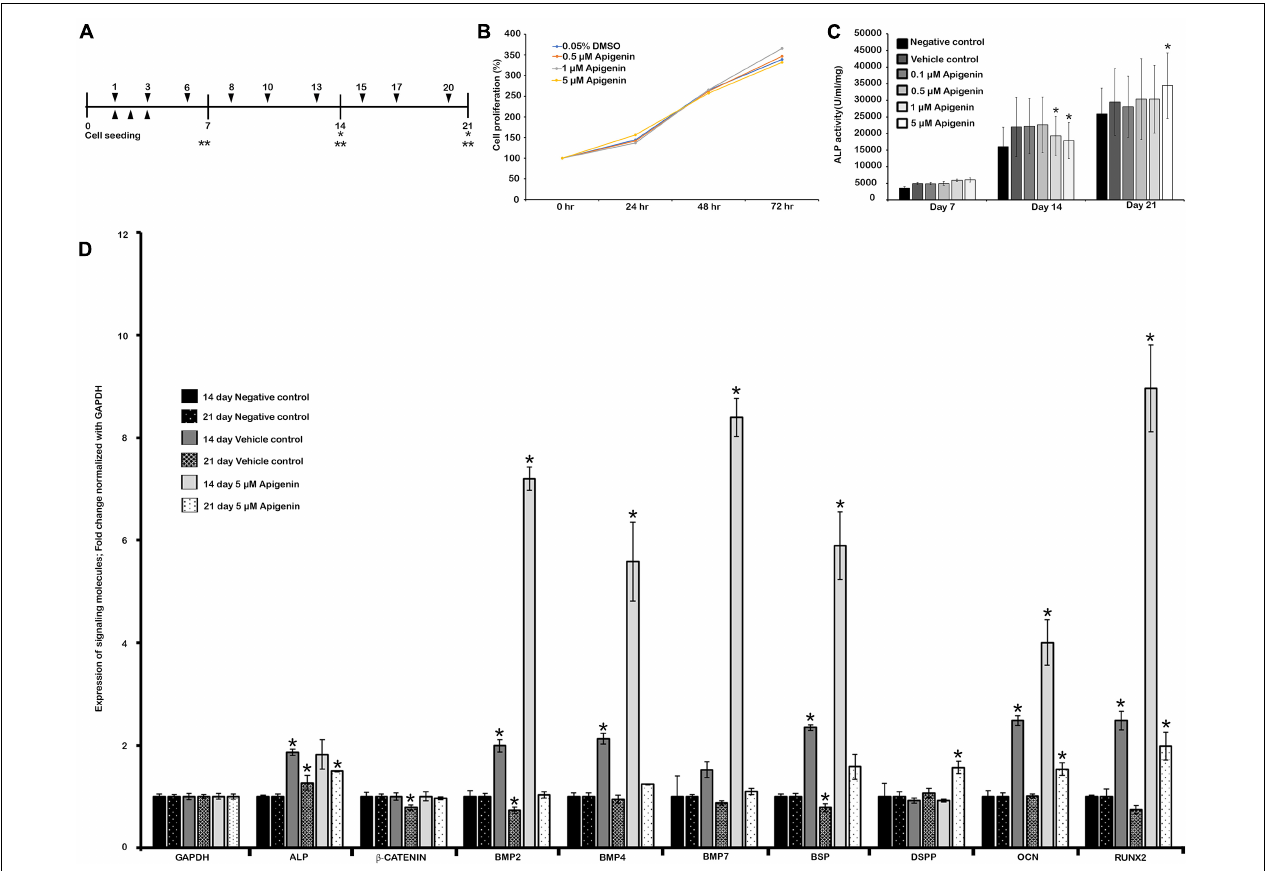
FIGURE 1 | Human dental pulp stem cells (hDPSCs) and apigenin treatment. Experimental design showing hDPSCs cultured with apigenin for 3 weeks (A) ; MTS assay showing cell viability and proliferation (B) ; the effect of apigenin on ALP activity in hDPSCs (C) ; altered expression patterns of signaling molecules after 5 µ M apigenin treatment on hDPSCs at days 14 and 21 (D) . The highest ALP activity is observed following treatment with 5 µ M apigenin at day 21. Bone morphogenetic protein (BMP)-related and osteogenesis-related signaling molecules are significantly upregulated in the apigenin-treated hDPSCs after 2 weeks. (cid:72) indicates the change of osteogenic medium, (cid:78) indicates MTS assay, * indicates real-time quantitative PCR (RT-qPCR), ** indicates ALP Assay (A) . * indicates p < 0.05 (C,D)